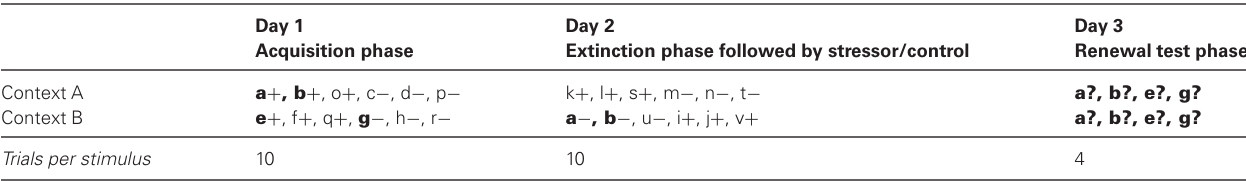
Table 1 | Design of the predictive learning